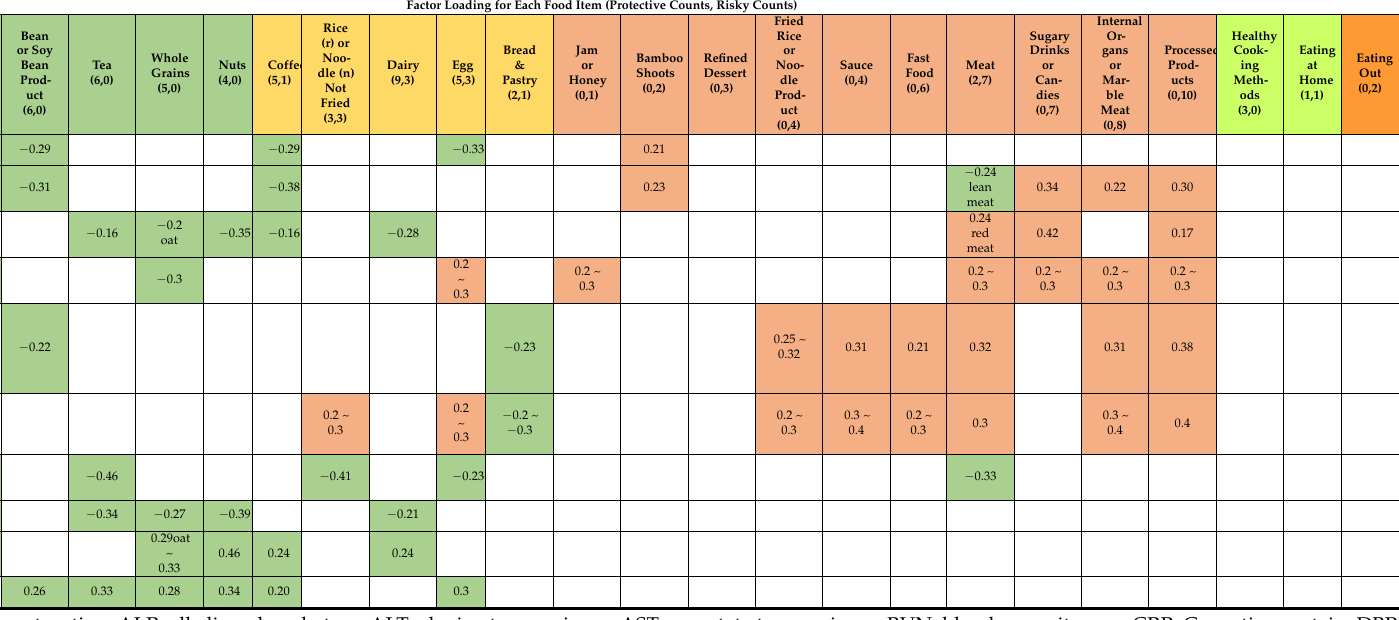
FactorLoadingforEachFoodItem(ProtectiveCounts,RiskyCounts)